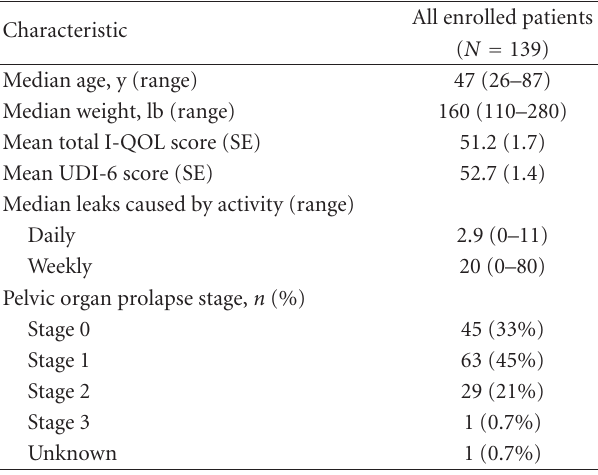
Table 1: Baseline characteristics of the study